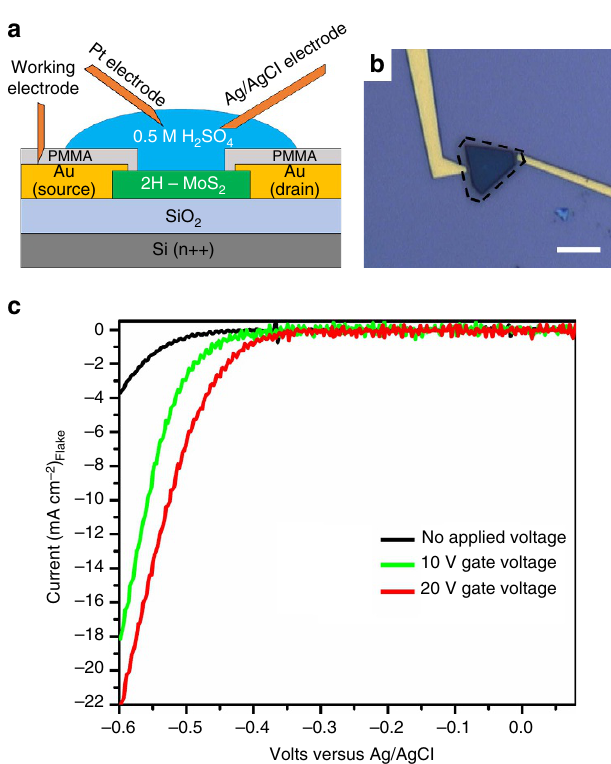
Figure 5 | Gate-Dependent HER. ( a ) Schematic of the gate-dependent electrochemical device, with the SiO 2 layer acting as the gate. ( b ) Optical micrograph of gold contacts and 2H-MoS 2 single layer flake. The edges of the MoS 2 flake masked with PMMA are outlined by the black dotted line, the exposed window can be seen as the darker region. Scale bar, 10 m m ( c ) Linear voltammograms from the gate-dependent HER measurements on the single MoS 2 flake device. The black curve is the activity of the flake with no applied voltage. The green and red curves show the improvement in electrocatalytic activity after applying a positive gate voltage of 10 and 20V, respectively.